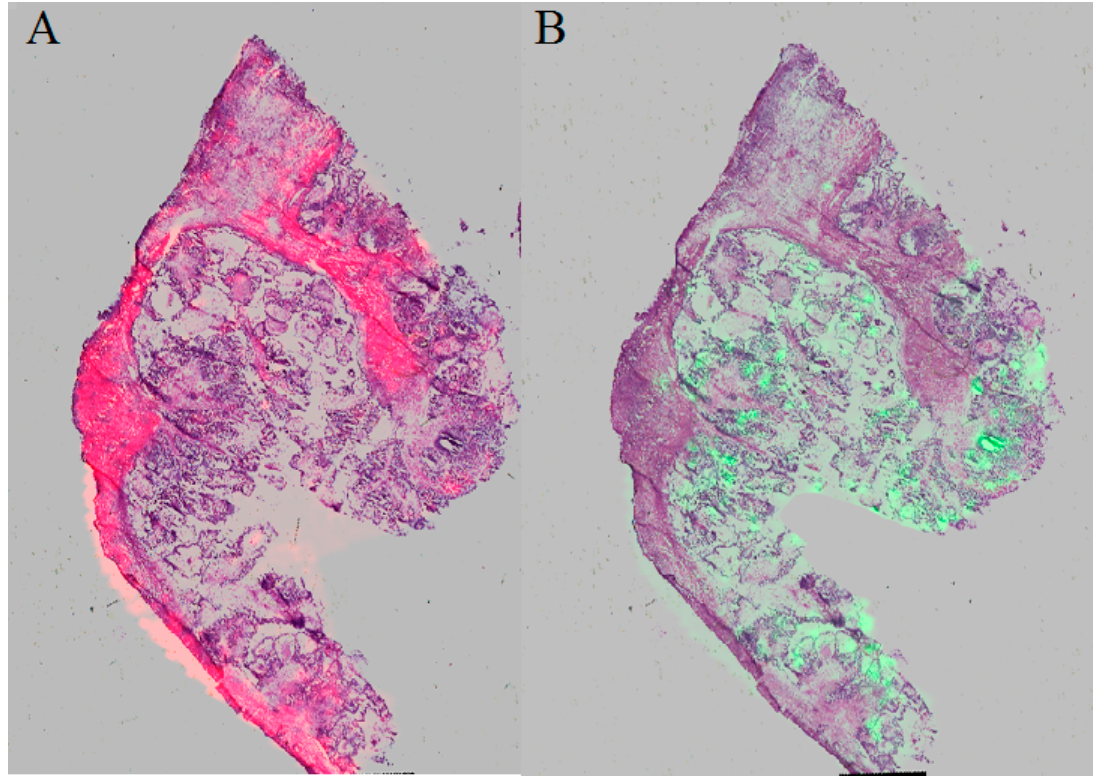
Figure 3. Picture A visualizing m/z: 4936.37 and 2775.79 characteristic of mesenchymal tissue and picture B visualizing m/z: 2861.35, 3368.34 and 3438.43 characteristic of epithelial tissue. Int. J. Environ. Res. Public Health 2020 , 17 , x